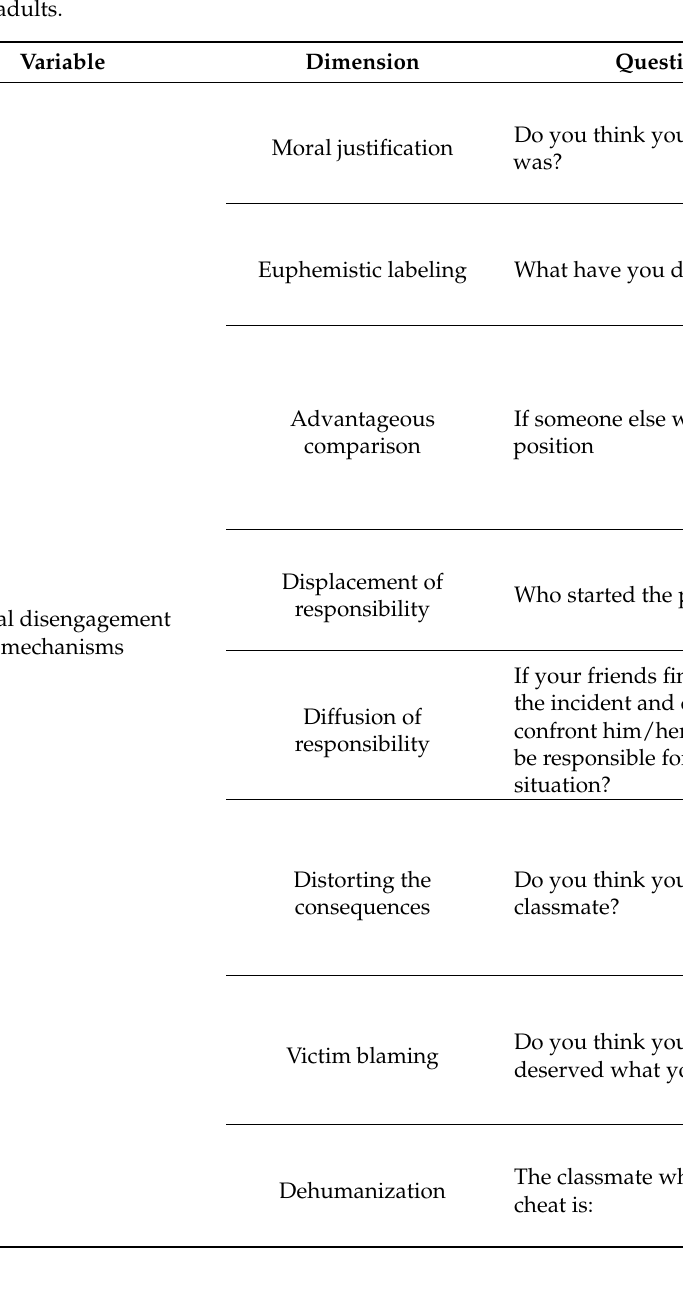
Moral disengagement